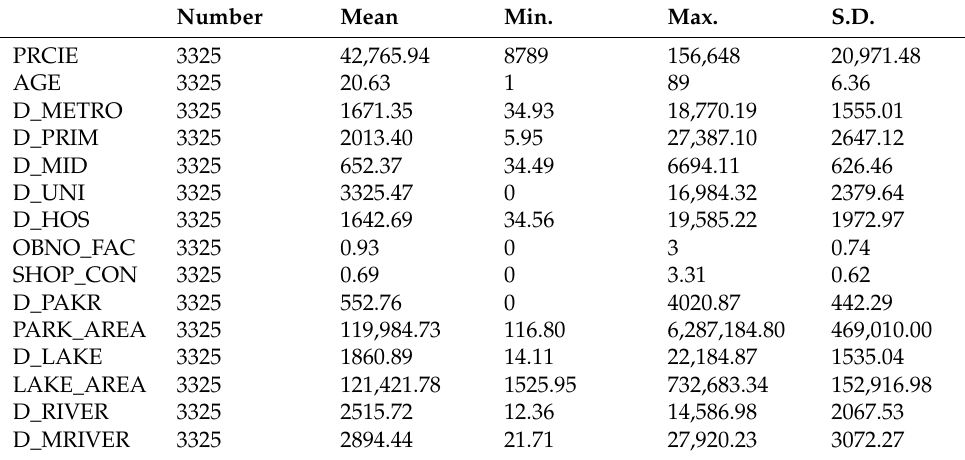
Table A3. Descriptive statistics of data in